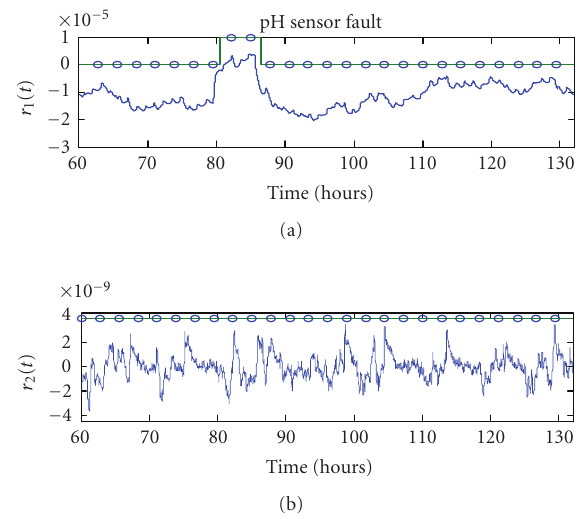
Figure 8: Behavior of r i ( t ), i = 1,2 and the decision test-fault-free situation.